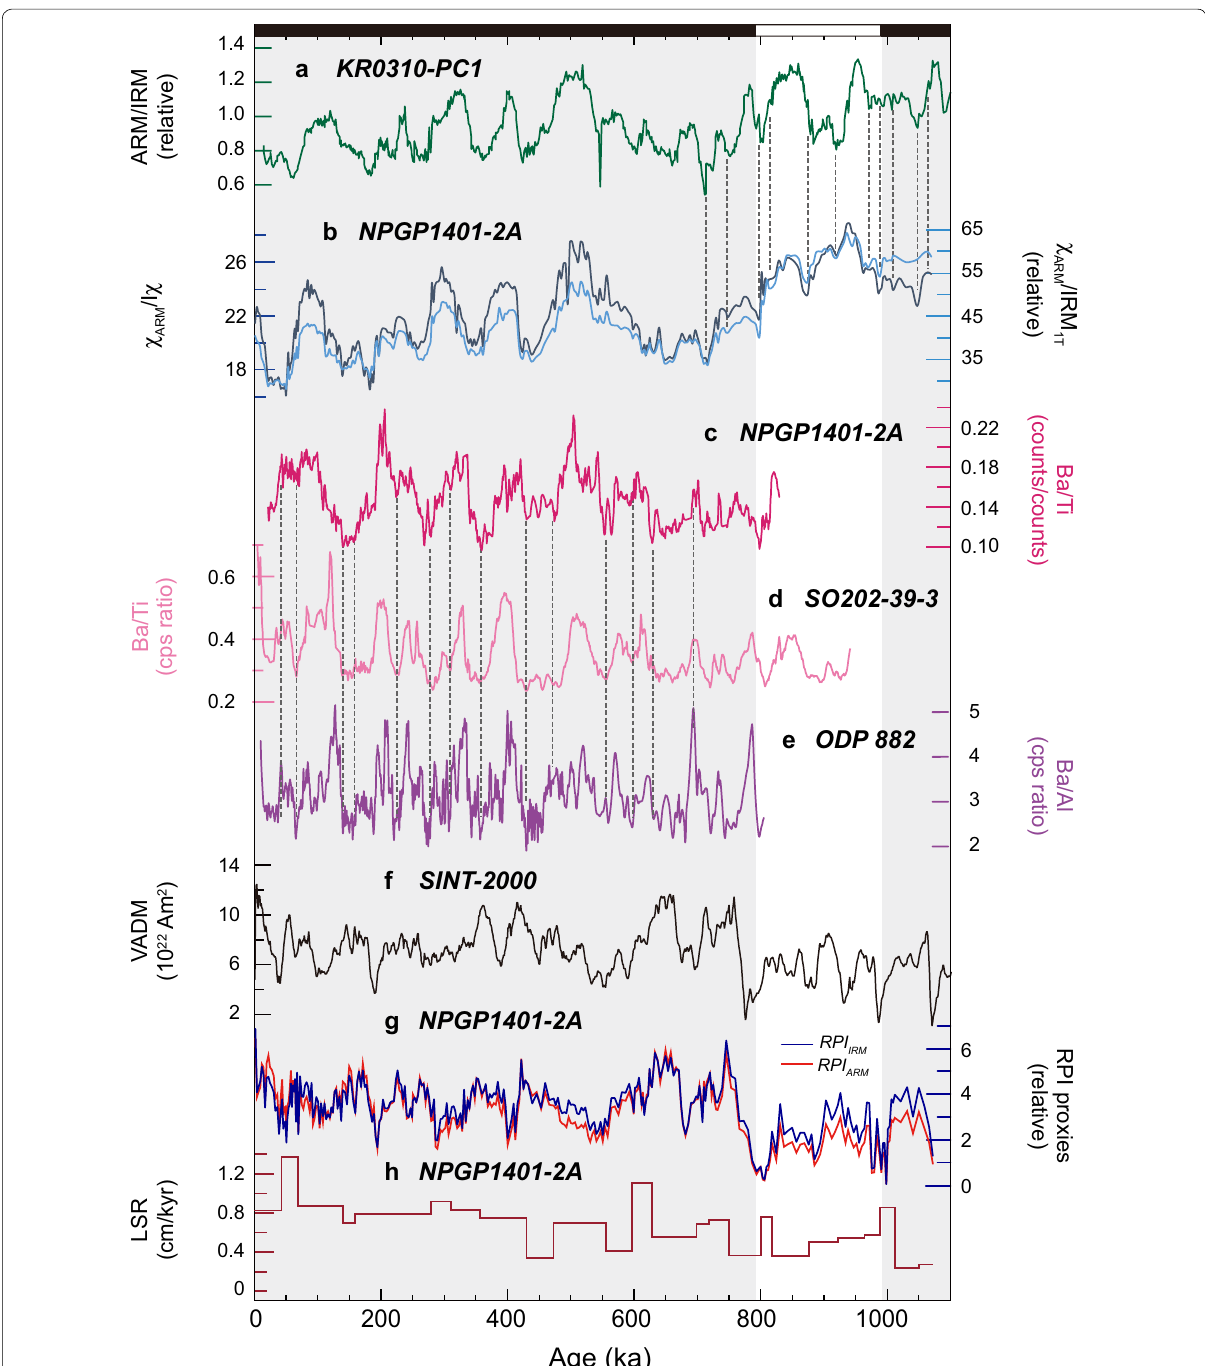
Fig. 7 Age model for NPGP1401-2A. a ARM/IRM of a reference core KR0310-PC1 (Yamazaki and Kanamatsu 2007) is correlated to b χ ARM /IRM 1T and χ ARM / χ of NPGP1401-2A for the older part (> ~ 700 ka). For the younger part, c Ba/Ti of NPGP1401-2A is correlated to d that of core SO202-39-3 (Korff et al. 2016) and e Ba/Al of ODP 882 (Jaccard et al. 2010). Temporal variations in f the SINT-2000 RPI stack (Valet et al. 2005) and g our RPI proxies (RPI ARM and RPI IRM ) are shown, and normal polarity chrons for NPGP1401-2A are marked as gray shades. h Linear sedimentation rate (LSR) calculated for the assigned age–depth